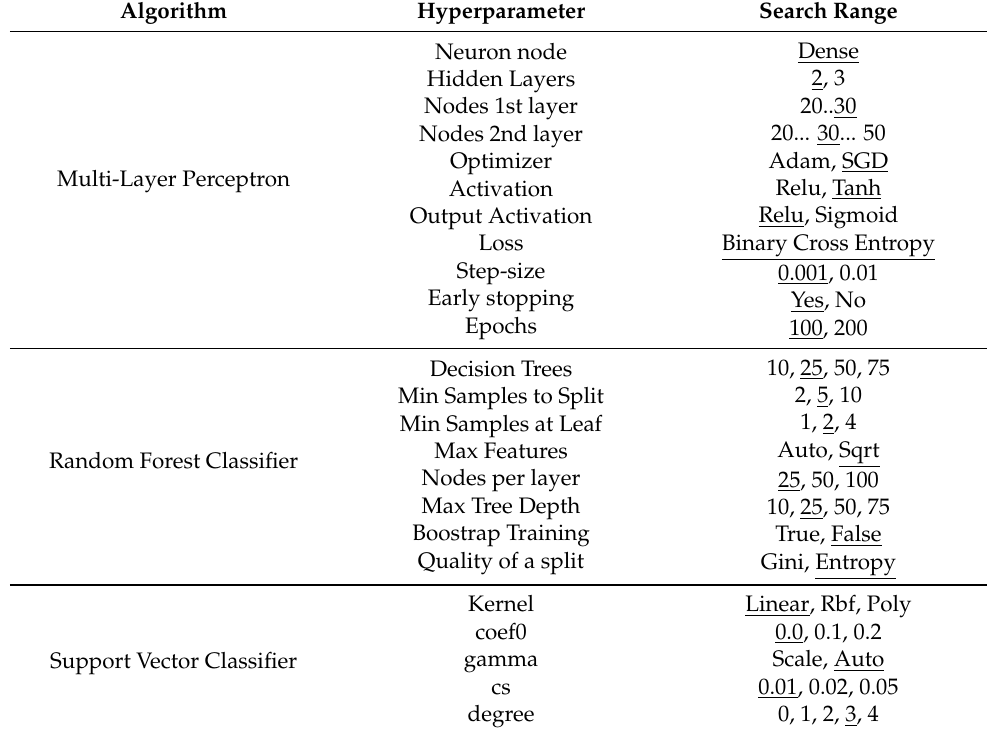
Table 2. Elbow point hyperparameter